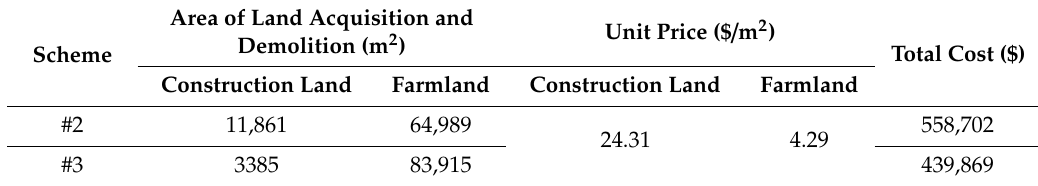
Figure 8. Schematic diagram of Scheme 2 and Scheme 3.